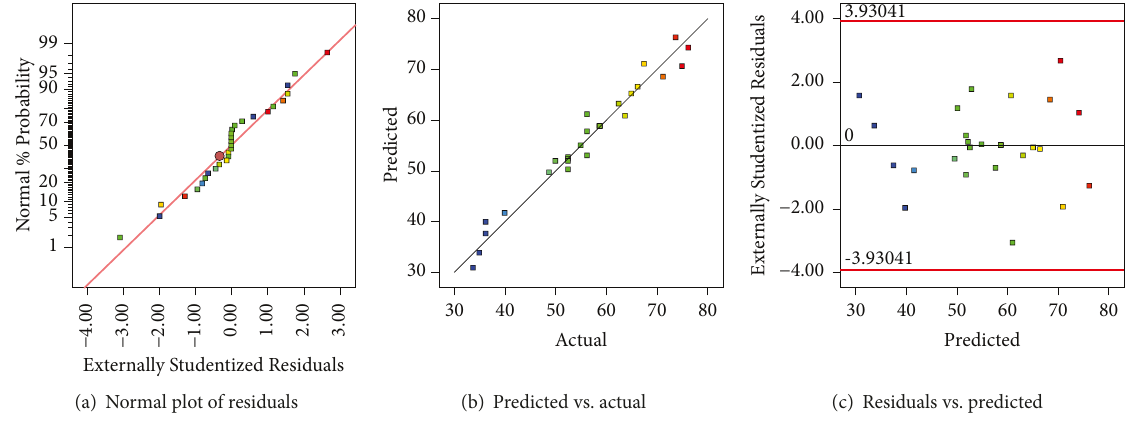
Figure 4: Data diagnostics. Table 7: Coefficients in terms of coded